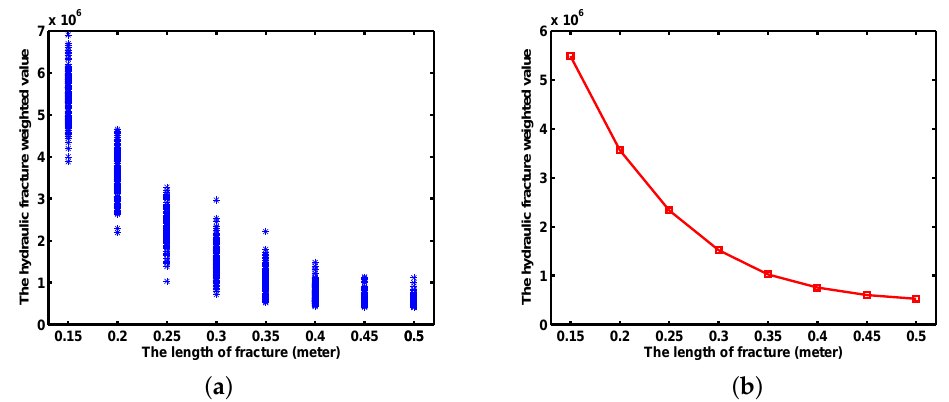
Figure 13. The influence of fracture length ( l ) on the hydraulic fracture weighted value. Here, α = 35 ◦ , n = 250, and the angle between two groups fracture keeps orthogonal. In addition, eight kinds of fracture lengths (0.15 m, 0.2 m, 0.25 m, 0.3 m, 0.35 m, 0.4 m, 0.45 m and 0.5 m) have been analyzed, with 150 groups of randomly generated fractures for each kind of fracture length. ( a ) scatter distribution of the hydraulic fracture weighted value with different values of l ; ( b ) average of the hydraulic fracture weighted value with different values of l